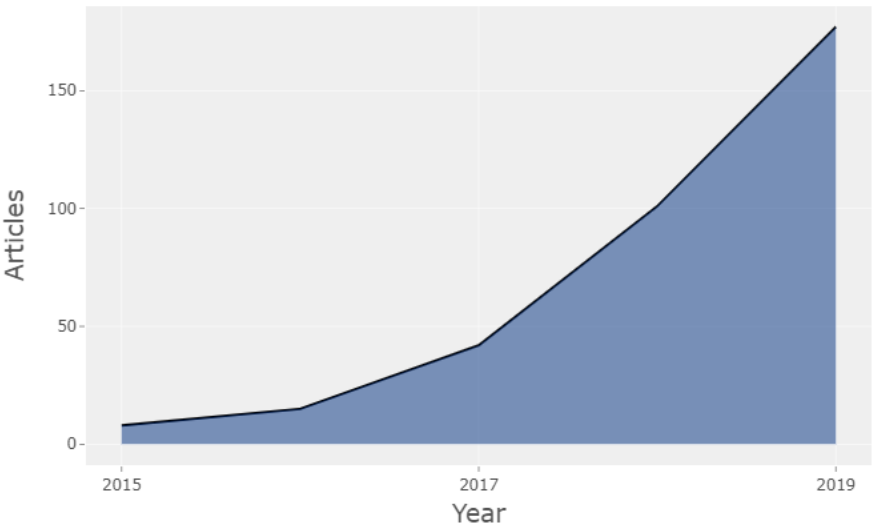
Figure 1. Annual Scientific Production (2015–2019). Table 3. Top 10 Most relevant sources